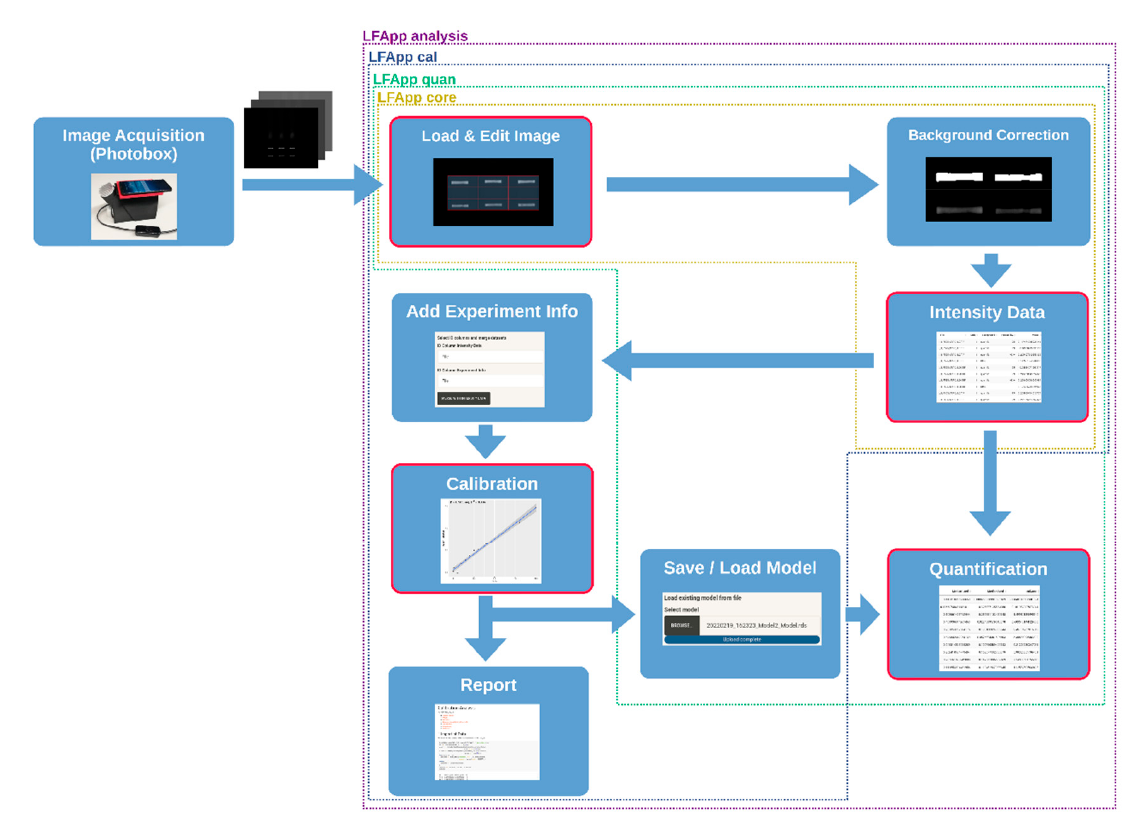
Figure 1. An overview of the content and workflow of our system. The different coloured frames indicate which modules are included in which application. The red border of modules represents optional starting points in the workflow.